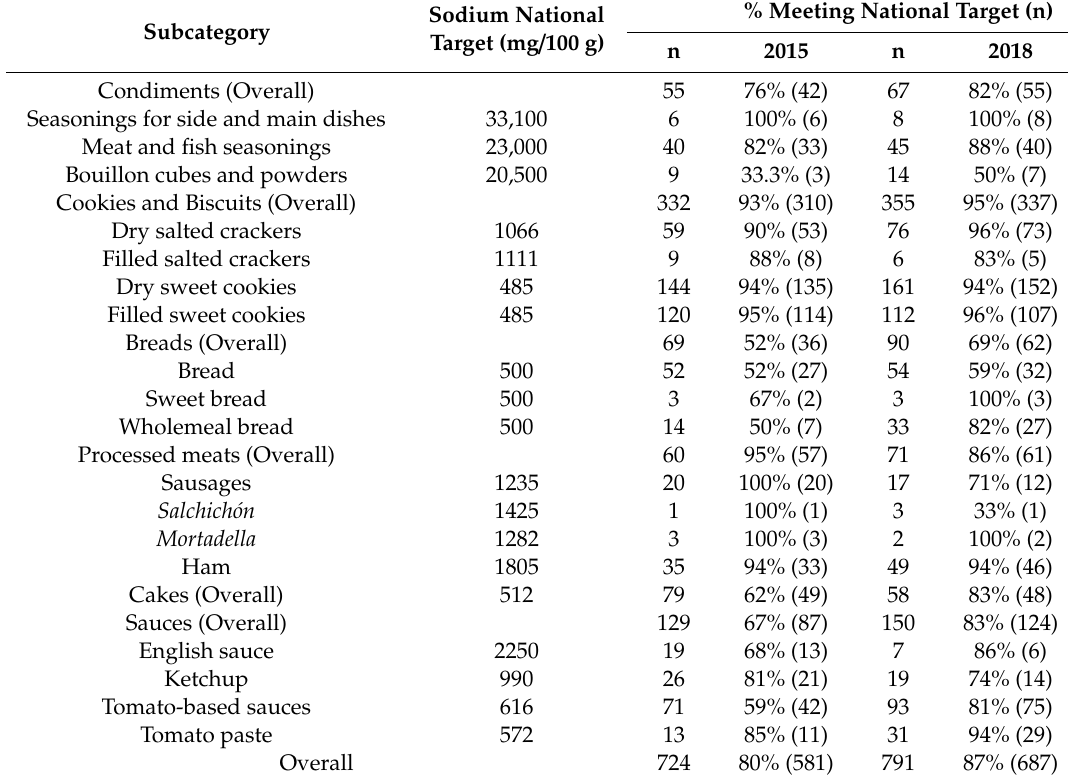
Table 2. Compliance with national target for the sodium reduction in packaged food by categories and subcategories, Costa Rica,